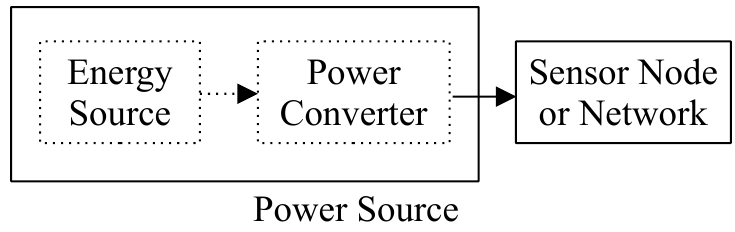
Figure 2. Simplified block diagram of a sensor network from the power source point of